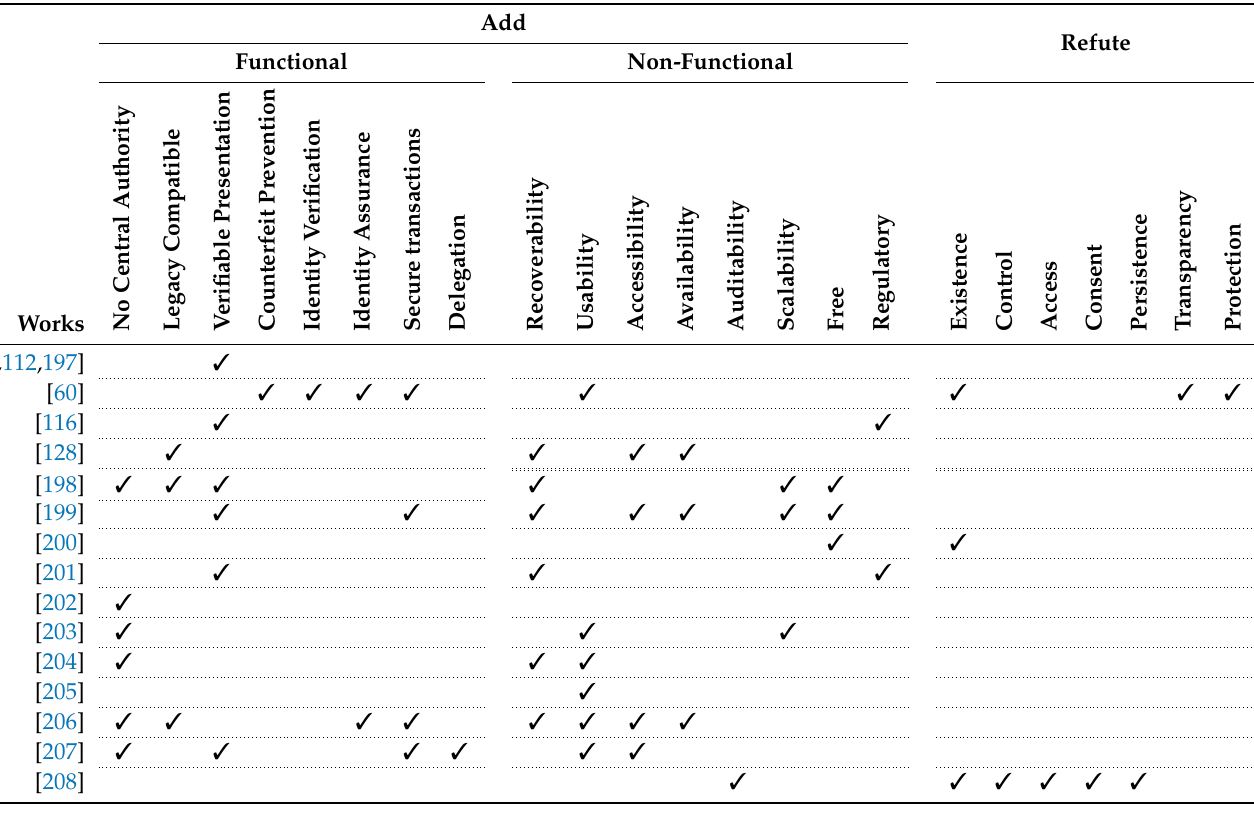
Table 7. Publications that add or refute philosophical views of SSI. Add Functional